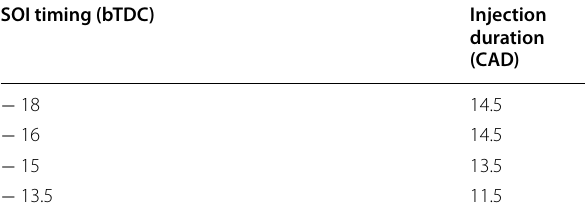
Table 10 Start of injection timings of biodiesel fuel SOI timing